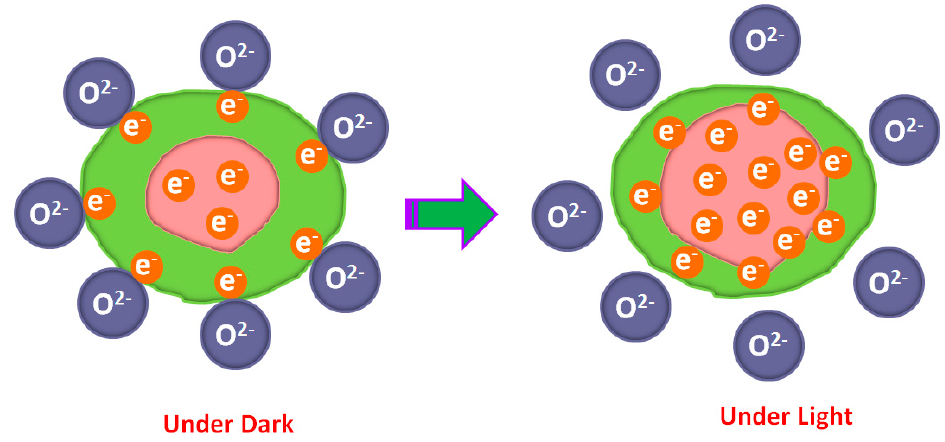
Figure 10. Mechanism of the photoconductivity of the Bi 2 S 3 thin film.